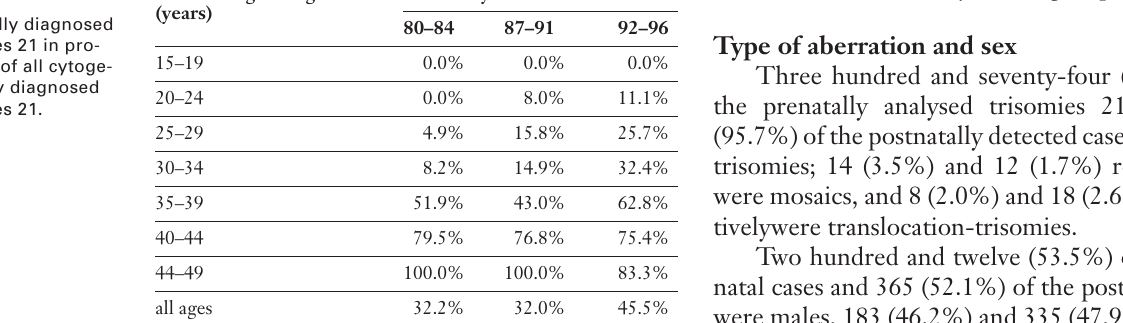
Prenatally diagnosed trisomies 21 in pro- portion of all cytoge- netically diagnosed trisomies